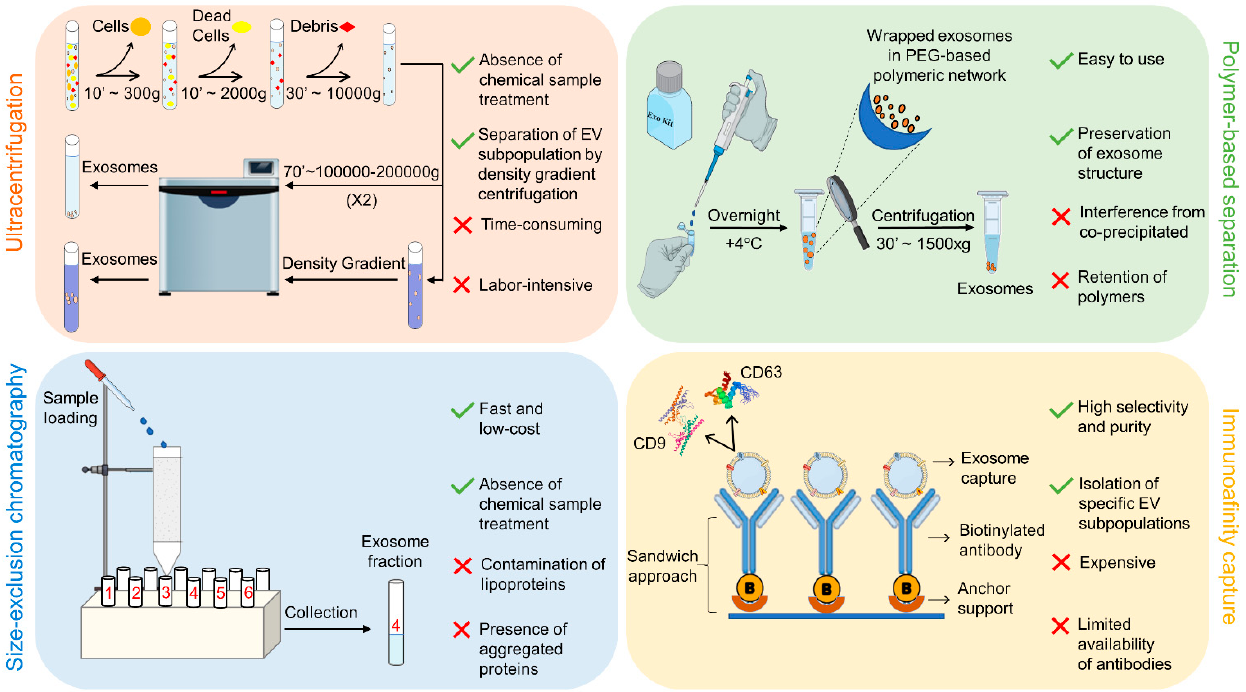
Figure 3. Schematic view of the different EXO purification